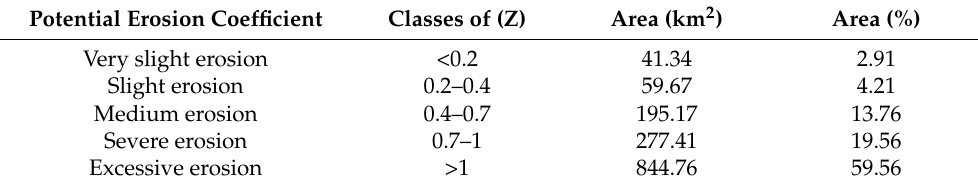
Table 5. Potential erosion coefficient.